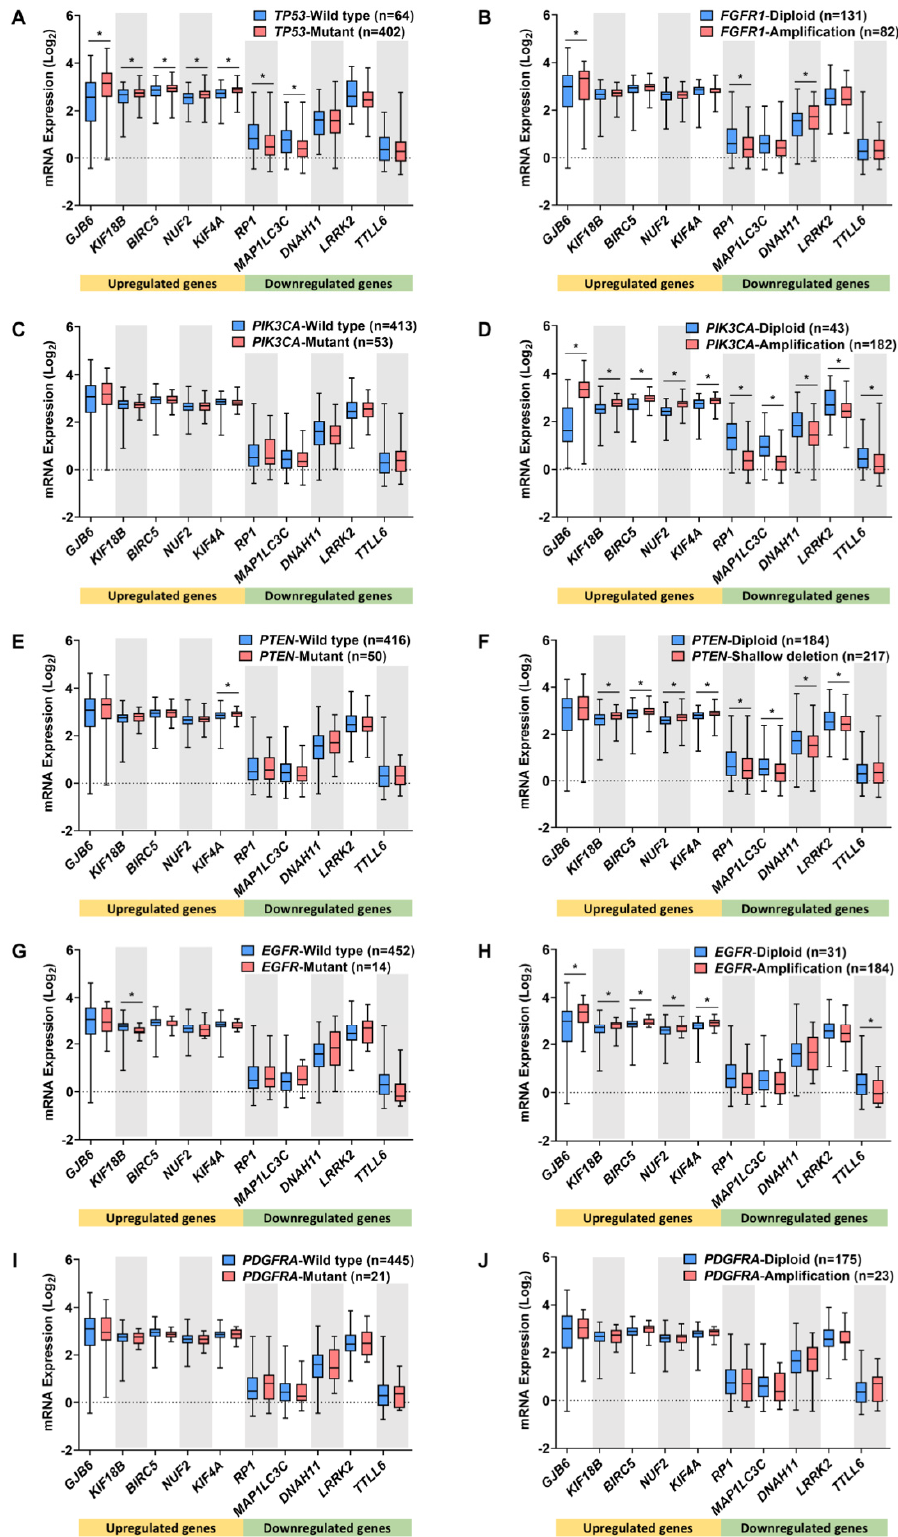
Figure 4. Relationships between the top five DEMG expressions in LUSC and its lung cancer hallmark gene alterations. Box plots demonstrate the association between DEMG expressions and mutation of TP53 ( A ), PIK3CA ( C ), PTEN ( E ), EGFR ( G ), and PDGFRA ( I ), amplification of FGFR1 ( B ), PIK3CA ( D ), EGFR ( H ), and PDGFRA ( J ), and shallow deletion of PTEN ( F ). * p < 0.05 vs. wild-type or diploid group.